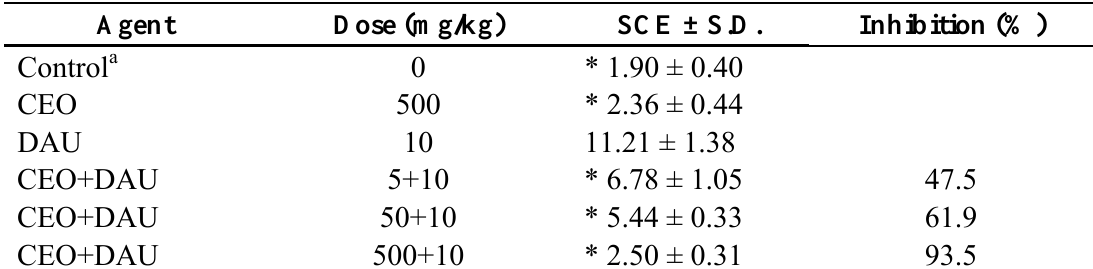
Table 2. Sister chromatid exchanges (SCE) in spermatogonial cells of mice treated with chamomile essential oil (CEO) and daunorrubicin (DAU).